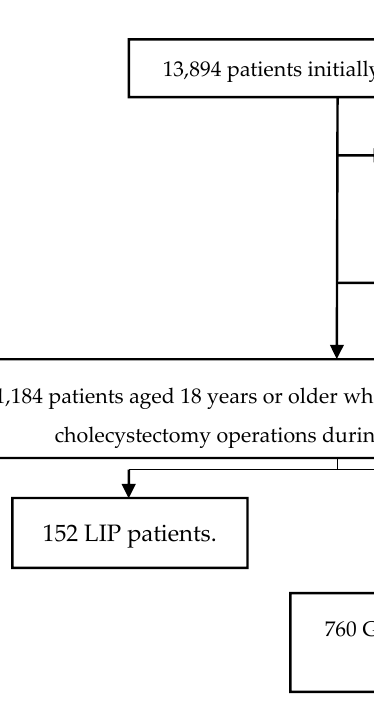
Figure 1. Patient selection flowchart. PC: percutaneous cholecystostomy; LIP: low-income population; GP: general population.